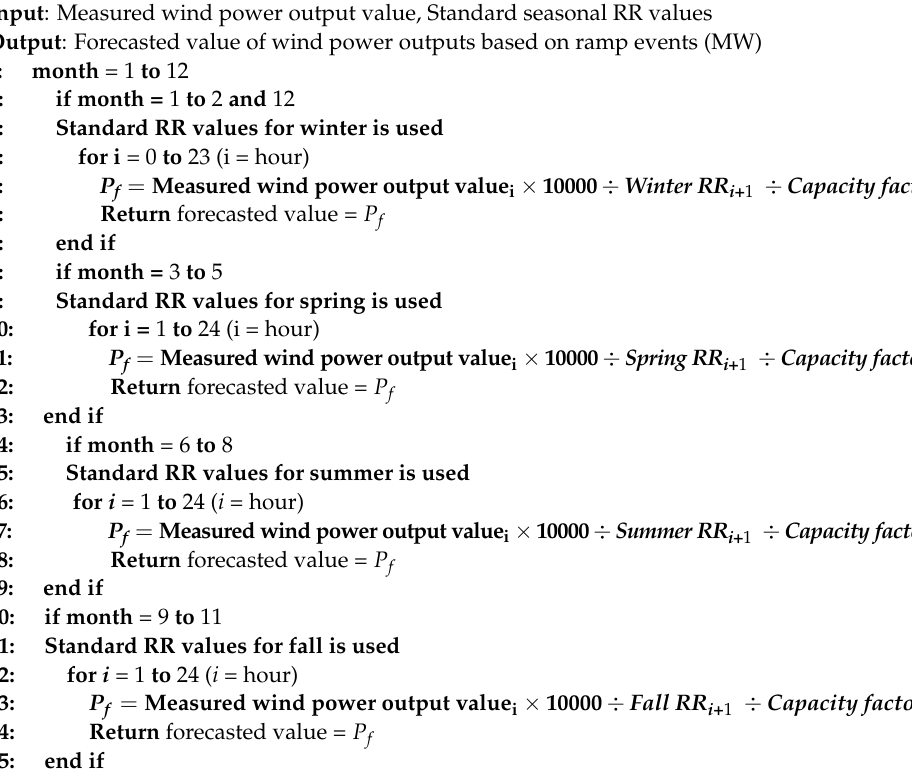
Algorithm 1. Wind power forecasting based on standard seasonal RR